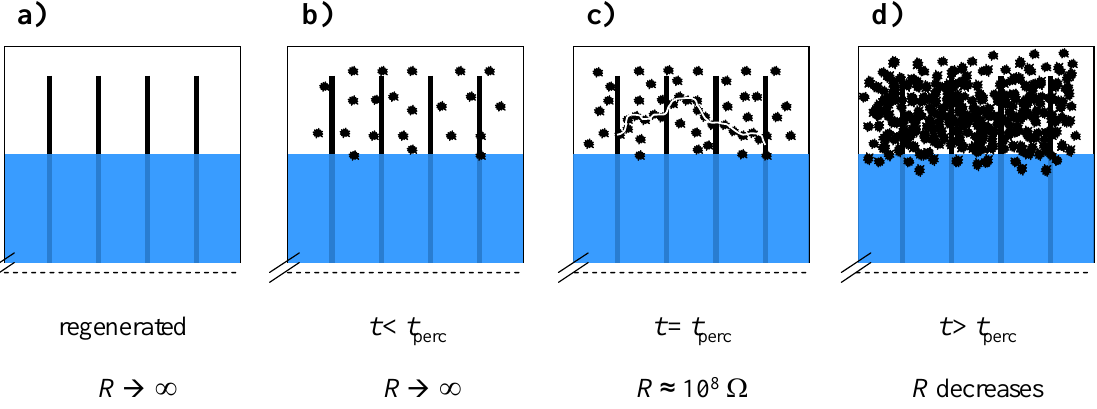
Figure 5. Schematic explanation of the resistance behavior during loading. For the meaning of (a) to (d) see